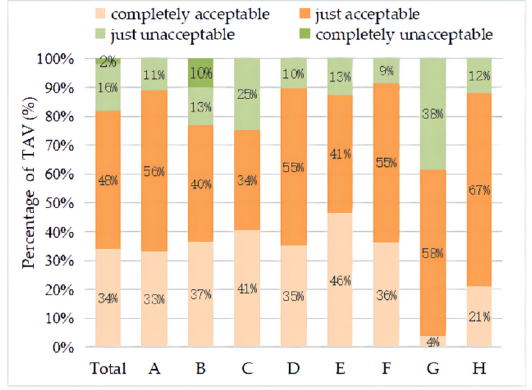
Figure 6. Percentage of TAV for the elderly in summer.